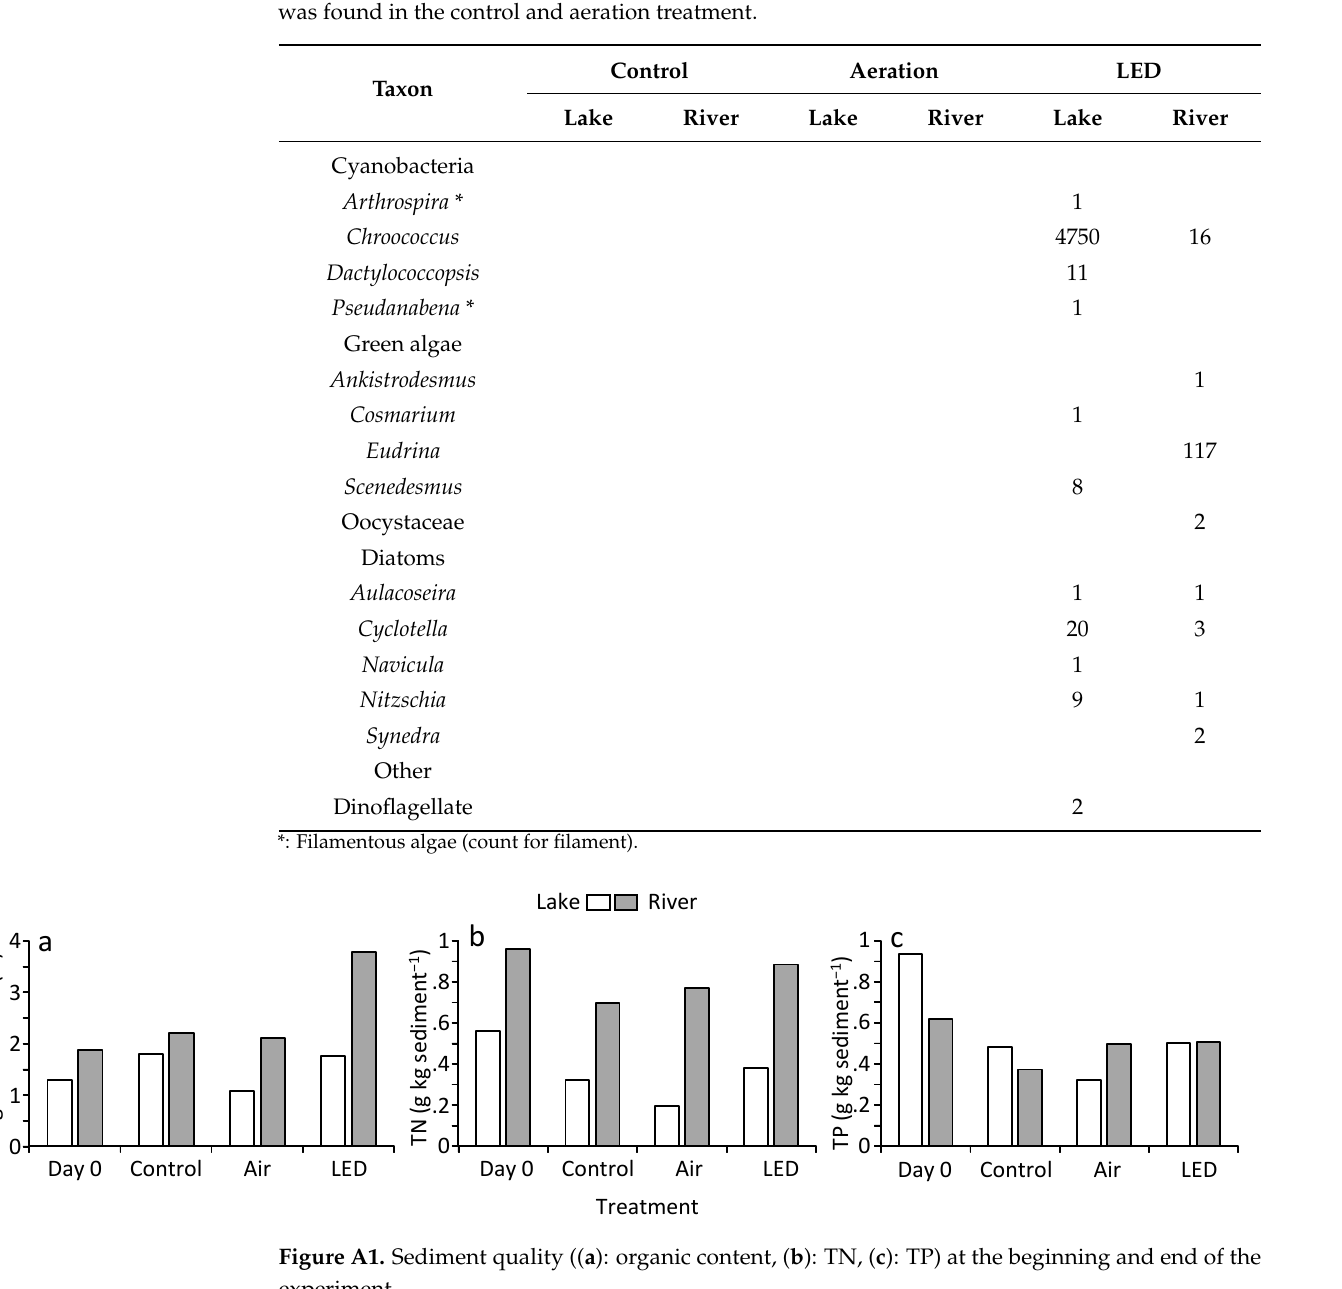
Figure A2. Diversity indices of the bacterial community in water and sediment samples. References 1. Harper, D.M. Eutrophication of Freshwaters: Principles, Problems and Restoration ; Springer: Dordrecht, The Netherlands, 1992; p. 327. 2. Dodds, W.K.; Bouska, W.W.; Eitzmann, J.L.; Pilger, T.J.; Pitts, K.L.; Riley, A.J.; Schloesser, J.T.; Thornbrugh, D.J. Eutrophication of US freshwaters: Analysis of potential economic damages. Environ. Sci. Technol. 2009 , 43 , 12 – 19. 3. Smith, V.H.; Schindler, D.W. Eutrophication science: Where do we go from here? Trends Ecol. Evol. 2009 , 24 , 201 – 207. 4. Rabalais, N.N.; Diaz, R.J.; Levin, L.A.; Turner, R.E.; Gilbert, D.; Zhang, J. Dynamics and distribution of natural and human- caused hypoxia. Biogeosciences 2010 , 7 , 585 – 619. 5. Søndergaard, M.; Jensen, J.P.; Jeppesen, E. Role of sediment and internal loading of phosphorus in shallow lakes. Hydrobiologia 2003 , 506 , 135 – 145. 6. Zamparas, M.; Zacharias, I. Restoration of eutrophic freshwater by managing internal nutrient loads. A review. Sci. Total Envi- ron. 2014 , 496 , 551 – 562. 7. Kibuye, F.A.; Zamyadi, A.; Wert, E.C. A critical review on operation and performance of source water control strategies for cyanobacterial blooms: Part I-chemical control methods. Harmful Algae 2021 , 109 , 102099. 8. Kibuye, F.A.; Zamyadi, A.; Wert, E.C. A critical review on operation and performance of source water control strategies for cyanobacterial blooms: Part II-mechanical and biological control methods. Harmful Algae 2021 , 109 , 102119. 9. Boström, B.; Andersen, J.M.; Fleischer, S.; Jansson, M. Exchange of phosphorus across the sediment-water interface. In Phospho- rus in Freshwater Ecosystems ; Persson, G., Jansson, M., Eds.; Springer: Dordrecht, The Netherlands, 1988; pp. 229 – 244. 10. Beutel, M.W. Inhibition of ammonia release from anoxic profundal sediments in lakes using hypolimnetic oxygenation. Ecol. Eng. 2006 , 28 , 271 – 279.